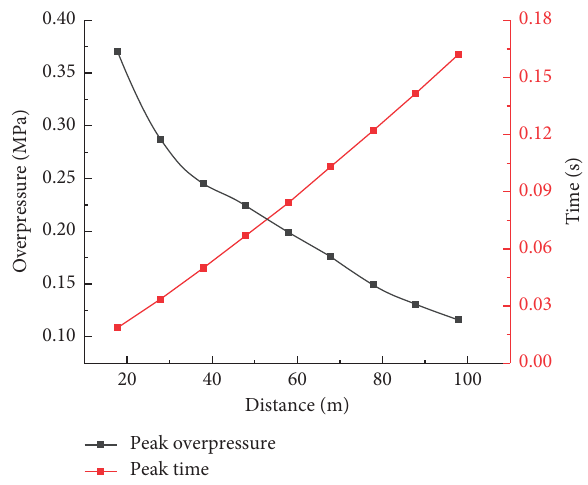
Figure 6: Peak overpressure and peak time change with distance.